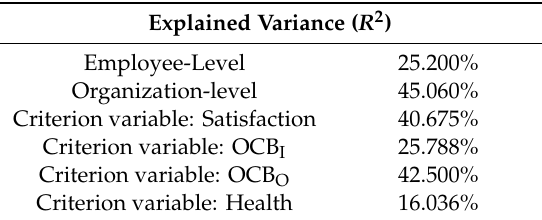
Table 6. Explained